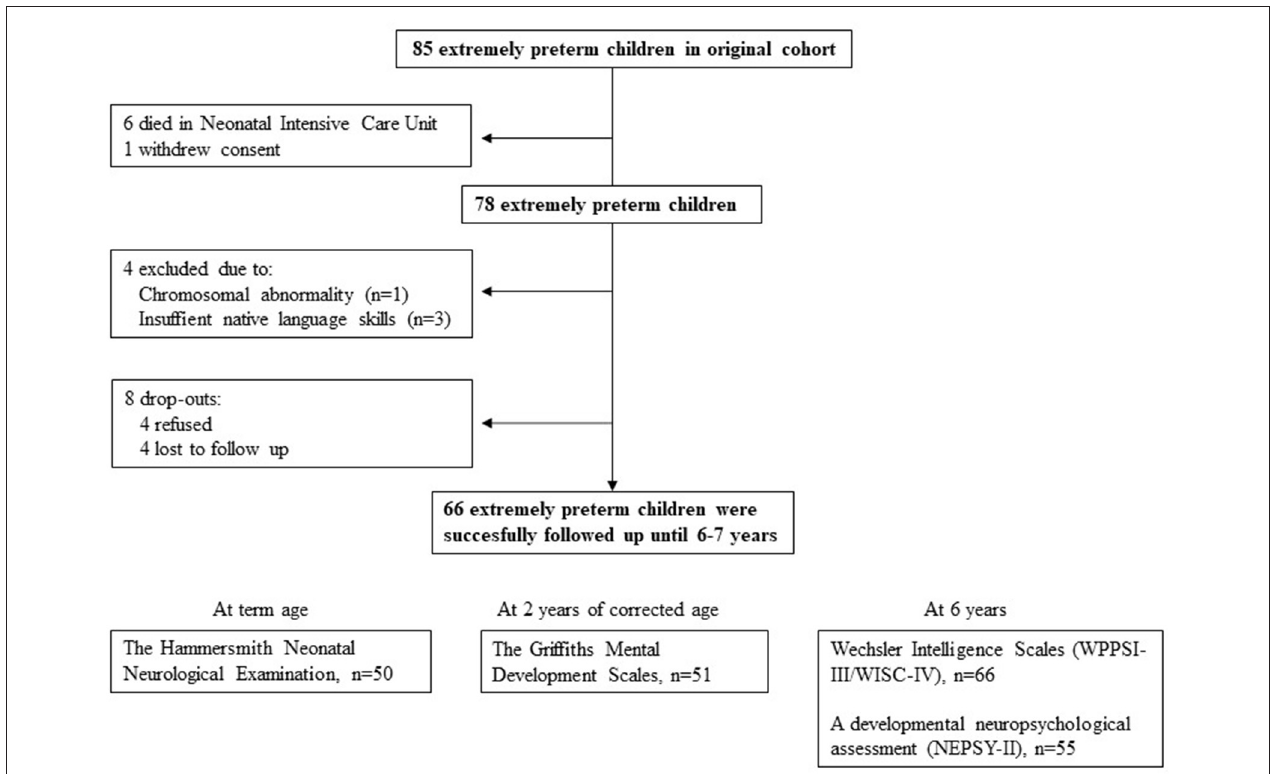
FIGURE 1 | Study flowchart and